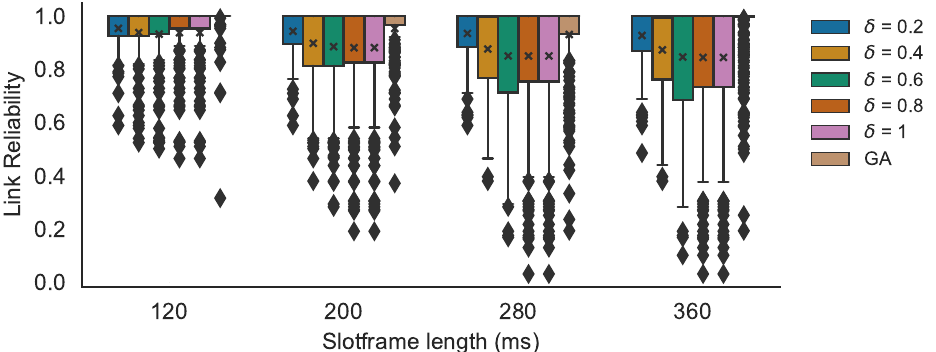
Figure 9. PDR simulation results for different δ values for different slotframe lengths, comparing the heuristic with the GA scheduler. The x denotes the mean value. The diamond shapes represent outliers that are values smaller than the minimum (i.e., the lower whisker) or larger than the maximum value (i.e., the top whisker).